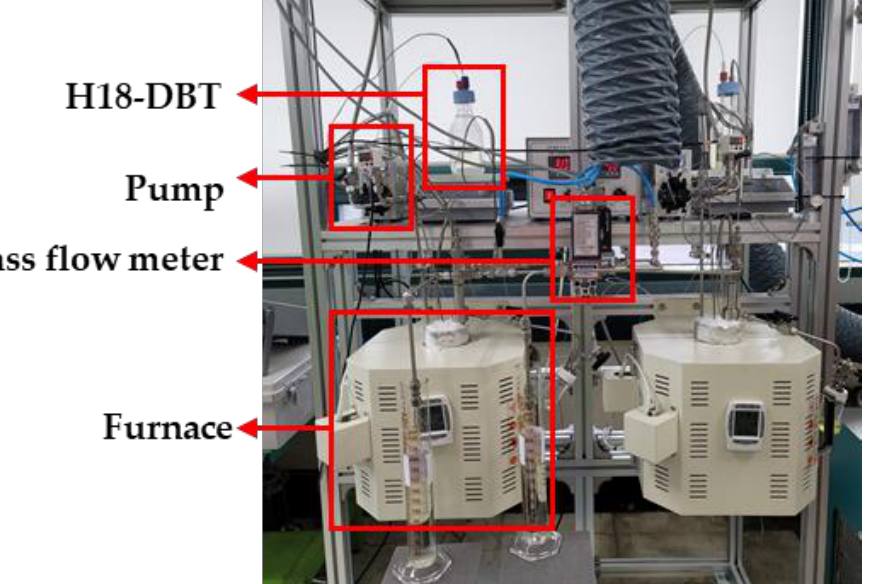
Figure 4. Two identical PFR reactor apparatus setups for investigating the dehydrogenation kinetics of H18-DBT.